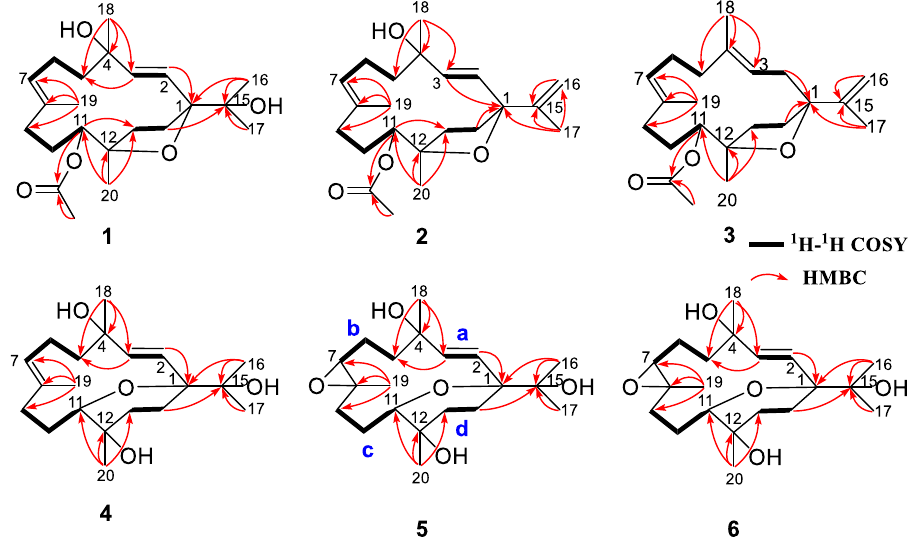
Figure 3. Selected key COSY and HMBC correlations for compounds 1 – 6 .